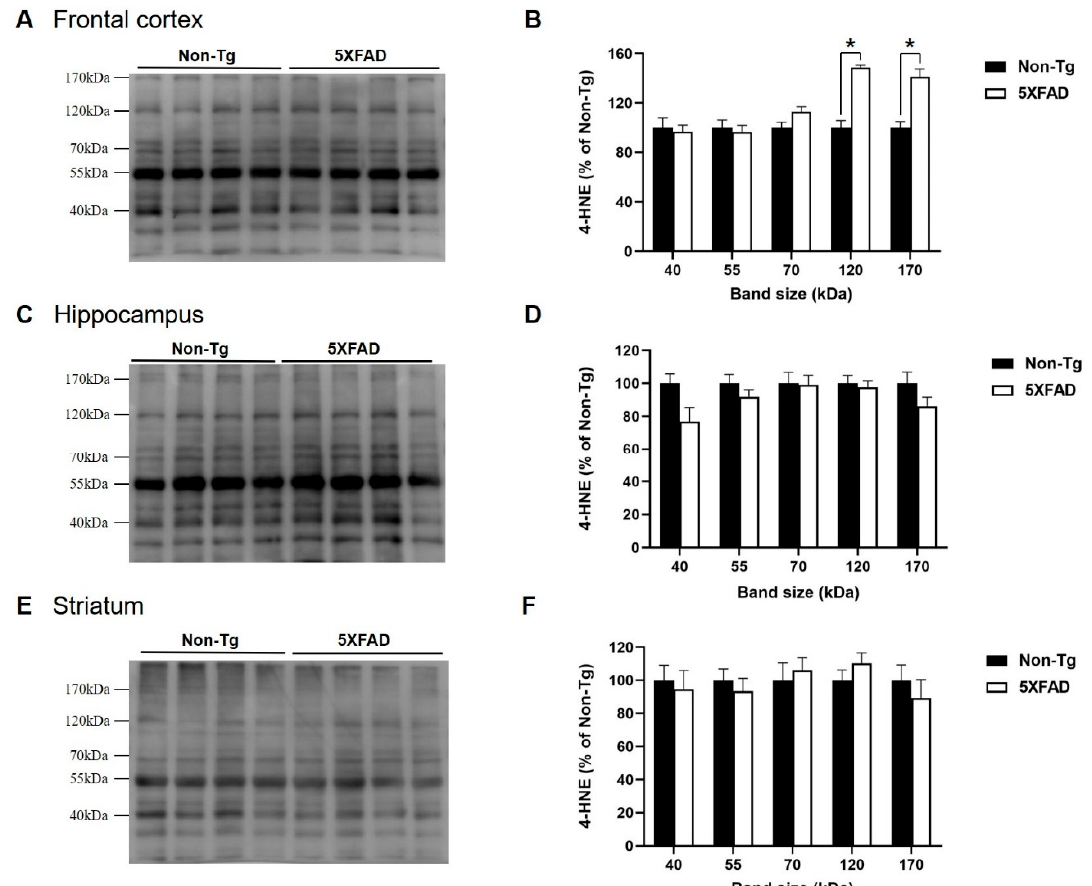
Figure 2. Increased levels of 4-HNE protein adducts in the frontal cortex of 4-month-old 5XFAD mice. Representative immunoblots of the frontal cortex ( A ), hippocampus ( C ), and striatum ( E ) of 4-month-old 5XFAD and non-Tg control mice. Five bands with evident immunoreactivity (40, 55, 70, 120, and 170 kDa) were selected and normalized according to 55 kDa band of Ponceau S staining. 4-HNE levels in the frontal cortex ( B ), hippocampus ( D ), and striatum ( F ) of 5XFAD mice represented as a percentage of the levels in non-Tg control mice. ( B ) 4-HNE levels in the frontal cortex of 5XFAD mice were significantly higher than those in non-Tg mice in specific band sizes (120 and 170 kDa). In the